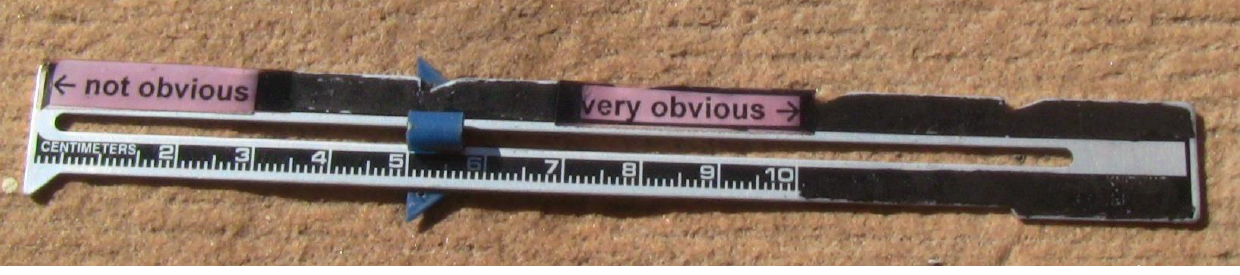
Figure 2. To indicate their responses, respondents used a modified hemming tool, a device familiar to them that helped them feel at